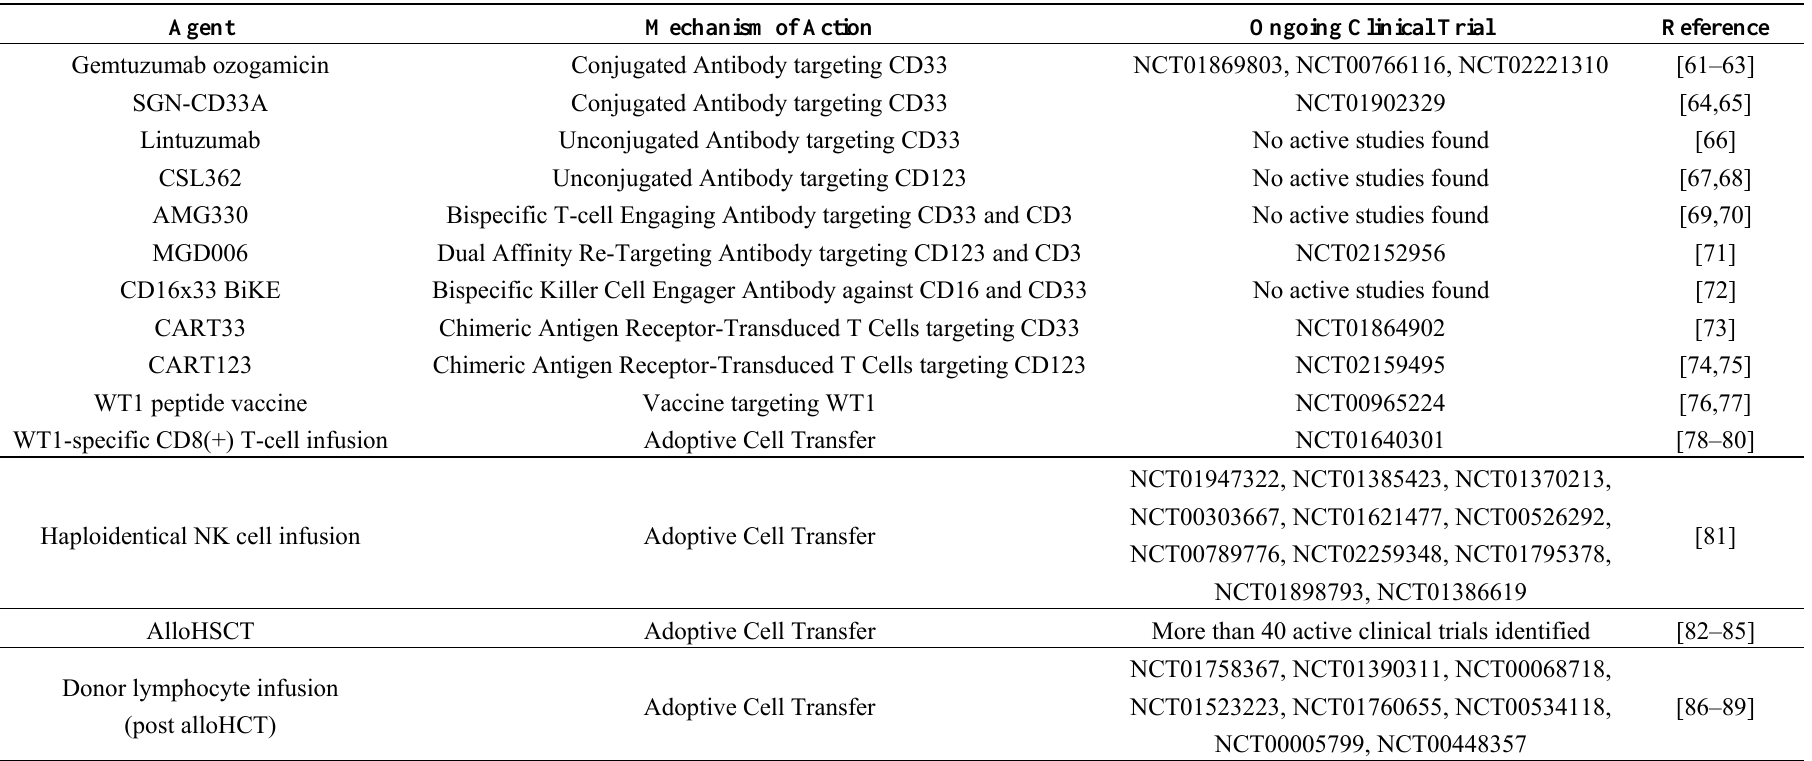
Table 3. Immunotherapeutic agents under evaluation for treatment of patients with relapsed/refractory